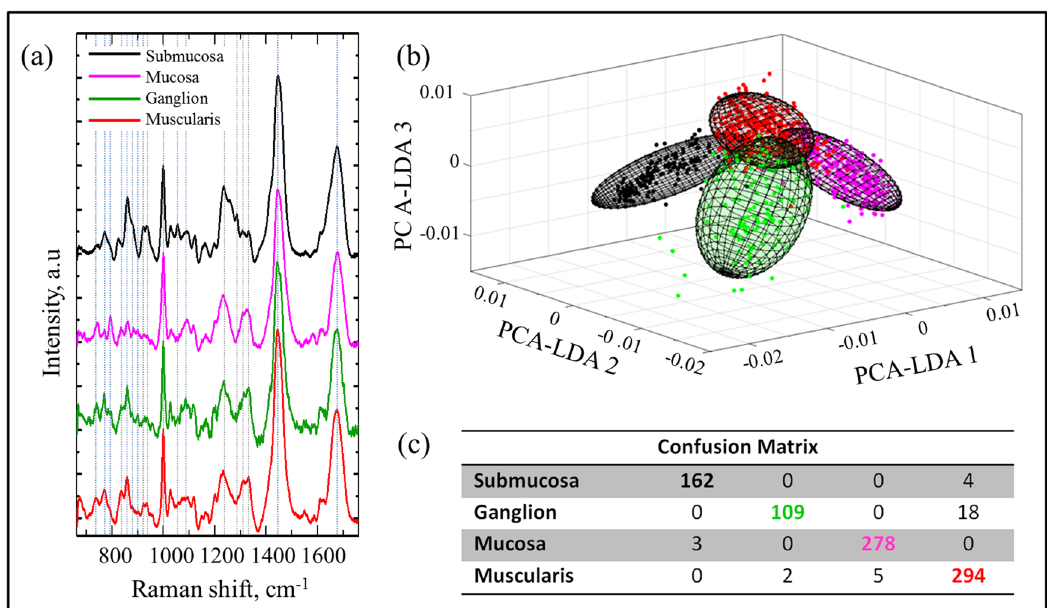
Figure 7. ( a ) Offset Raman average spectra from the 4 different groups. ( b ) 3D PCA-LDA plot with 90% interval confidence covariance error ellipsoids and ( c ) confusion matrix by using the classification